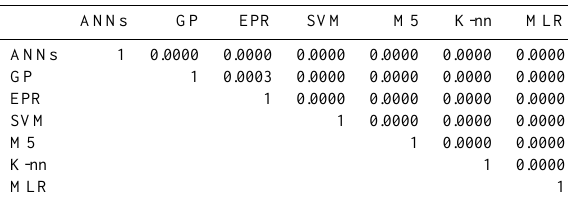
Table 16. The p -values of the two samples K-S test on the model residuals (rainfall-runoff